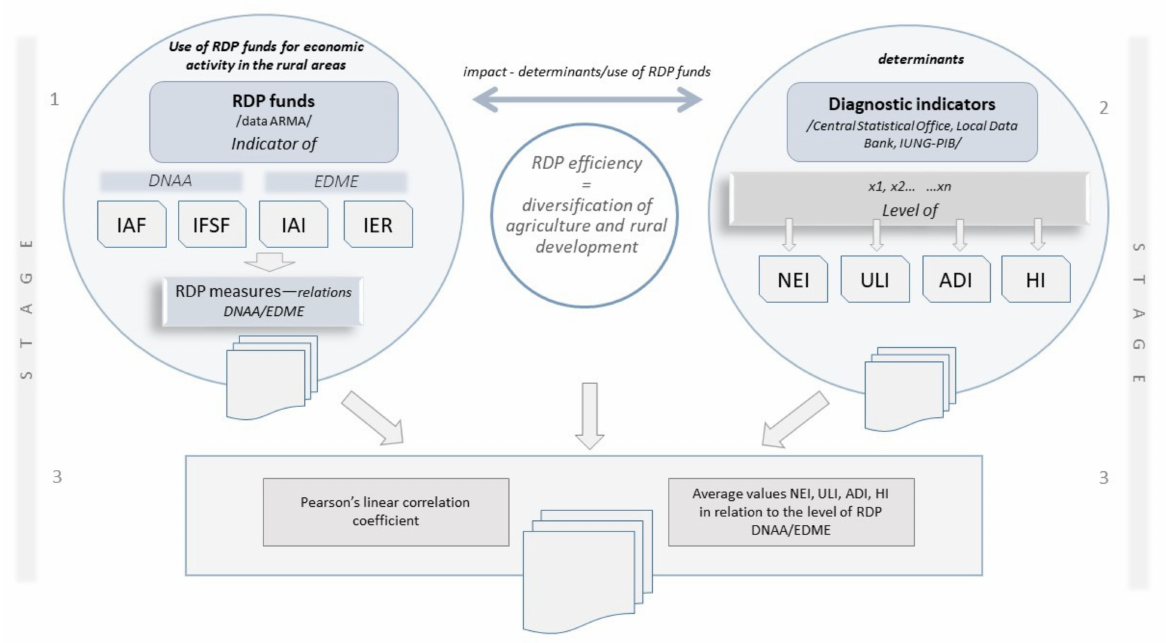
Figure 1. Research procedure. Source: own elaboration RDP—Rural Development Program; ARMA—Agency for Restructur- ing and Modernisation of Agriculture; DNAA—Diversification into non-agricultural activities; EDME—establishment and development of micro-enterprise; IAF—the activity of farmers (farm owners); IFSF—impact on the economic situation; IAI activity of inhabitants of rural areas; IER—economic rank; NEI—natural environment quality indicator; ULI—urbanization level indicator; ADI—agricultural development level indicator; HI—historical